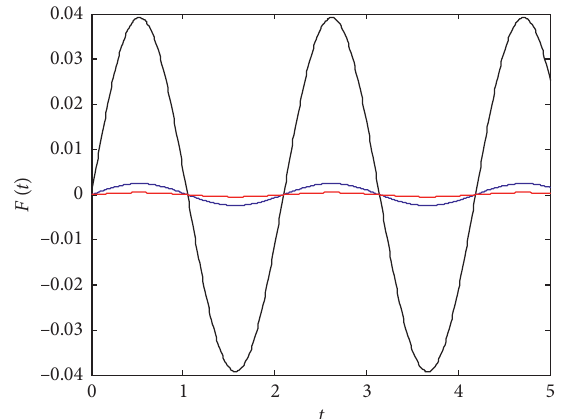
Figure 3: The change curve of first 3 orders of related time function F r ( t ) with time t (s) of the